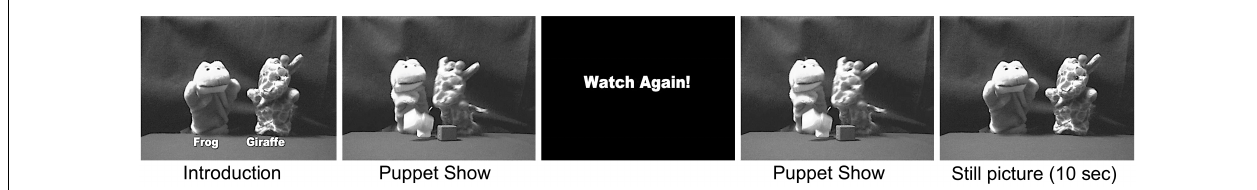
FIGURE 1 | The Sequence of a Puppet Show. The sequence of a puppet show from the introduction of the characters to the still picture (10 s). Each show was presented twice in immediate succession with the “Watch Again!” slide as a cue for the second presentation.